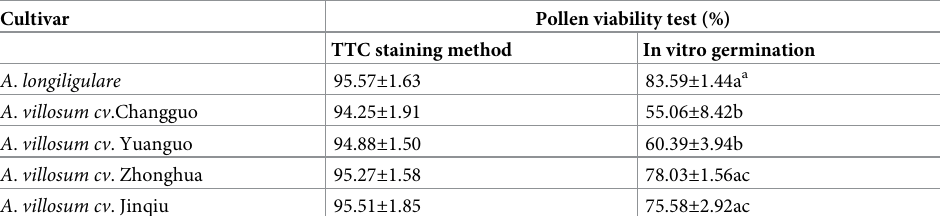
Table 3. Viability of fresh pollens was confirmed by the TTC staining method and in vitro germination in herba- ceous Amomum